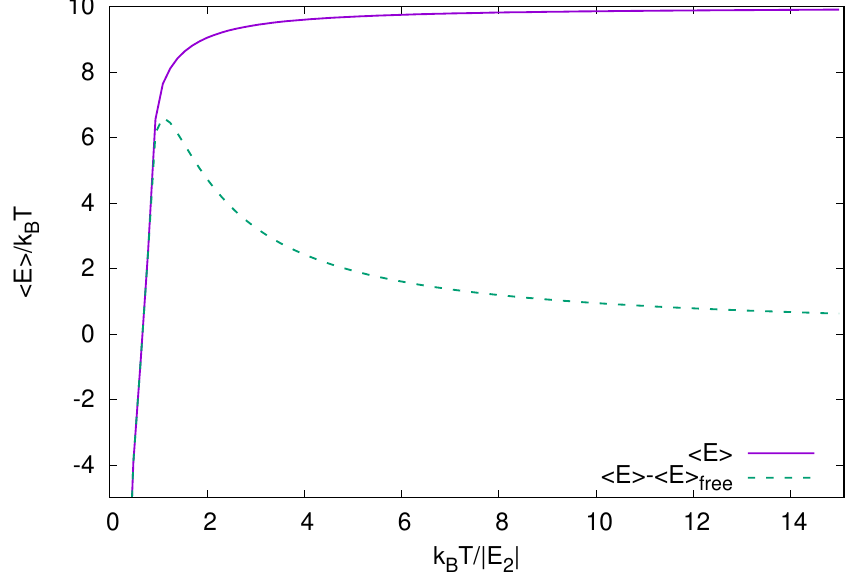
Figure 7. This plot shows the same as in Figure 5, but for two-particle-per-layer system. The energy curve again starts at large negative energies, then approaches the high-temperature limit of 10 k B T (the equipartition limit for 10 total particles in 1D harmonic potentials). The curve showing the difference of energies starts to separate from the energy curve at k B T / E 2 ≈ 1 as the free-particle state becomes populated before rapidly turning over and descending towards the high-temperature limit of 0. In contrast with the single particle per layer system, the high-temperature limits are achieved much more slowly. The interaction strength for this plot was U =